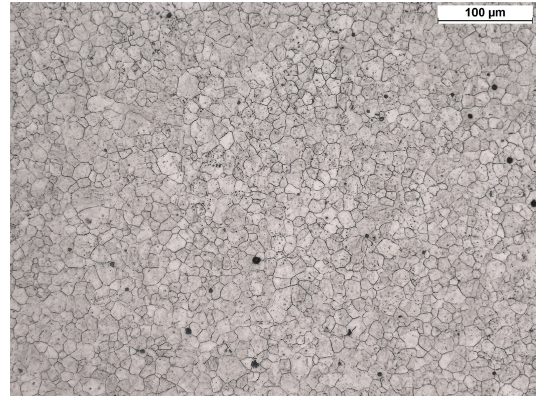
Figure 6. Prior austenitic grains for the austenitizing temperature of 920°C. Etchant: Teepol. OM. 200x.